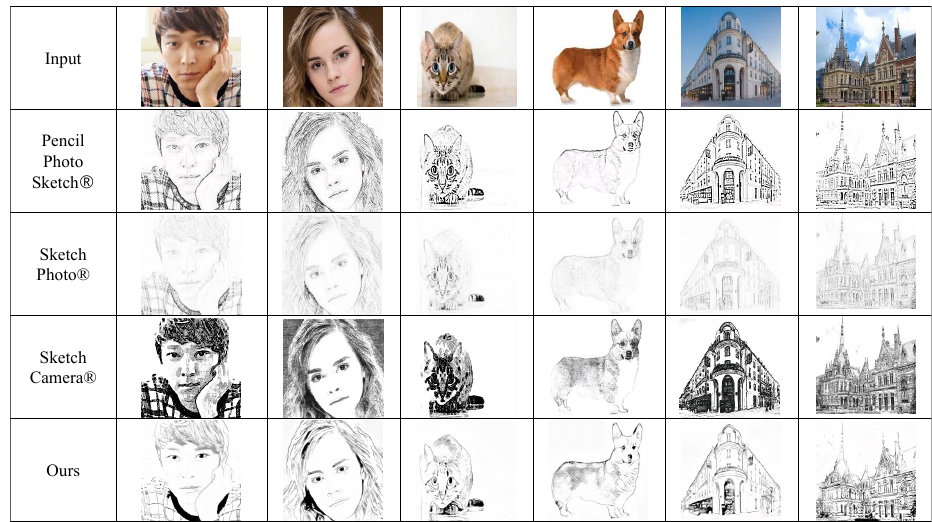
Figure 14. Comparison with the apps available on mobile phones: Pencil Photo Sketch (cid:114) , Sketch (cid:114) (cid:114) Photo and Sketch Camera